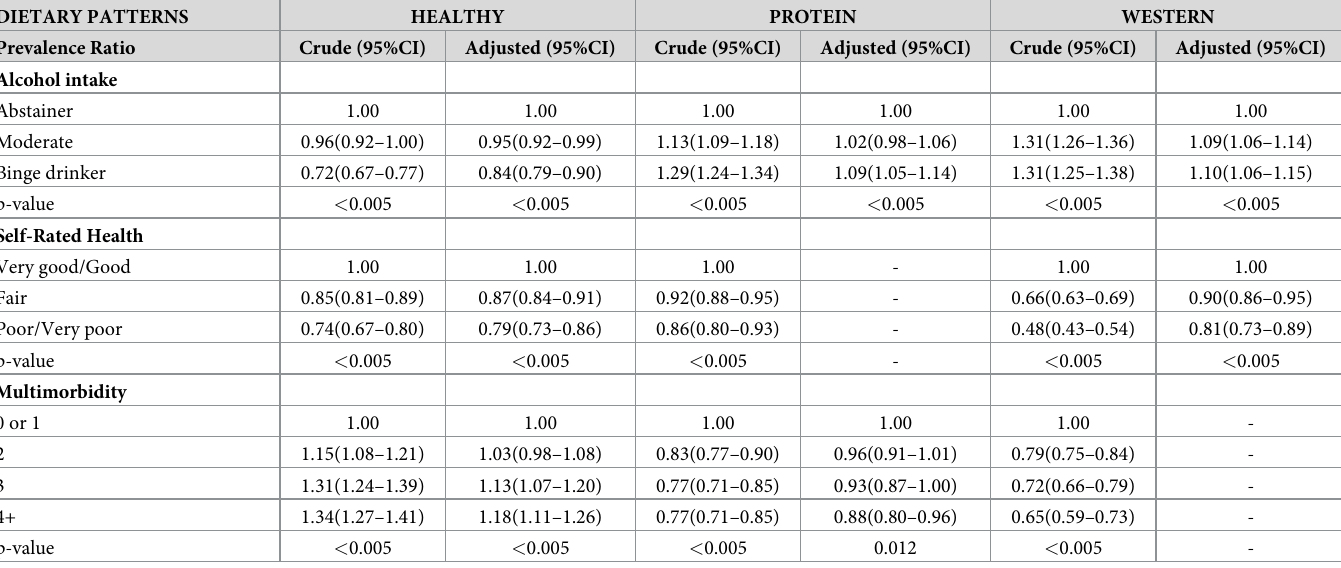
Younger participants also showed higher adherence to the western pattern (PR: 1.80; 95% CI: 1.68–1.93) compared to the elderly. Adherence to the western pattern was less frequent among black, brown and indigenous participants compared to white and East Asian partici- pants together. Overall, the western pattern was significantly less common among illiterate participants (PR: 0.54; 95% CI: 0.48–0.61) compared to those holding a university degree. In the North, rural residence was inversely associated with the western pattern compared to those living in the urban area (PR: 0.29; 95% CI: 0.21–0.40). Rural dwellers in other